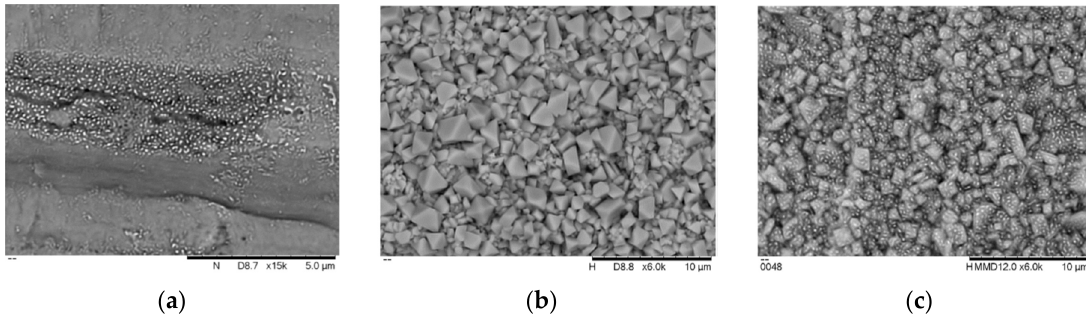
Figure 10. SEM micrographs of the Pt/as ‐ received SSM catalyst showing Pt aggregation after hydrogen exposure ( a ), SSM calcined at 1000 °C ( b ), and Pt/calcined SSM after hydrogen exposure ( c ) (reproduced from [129] with permission from Elsevier).